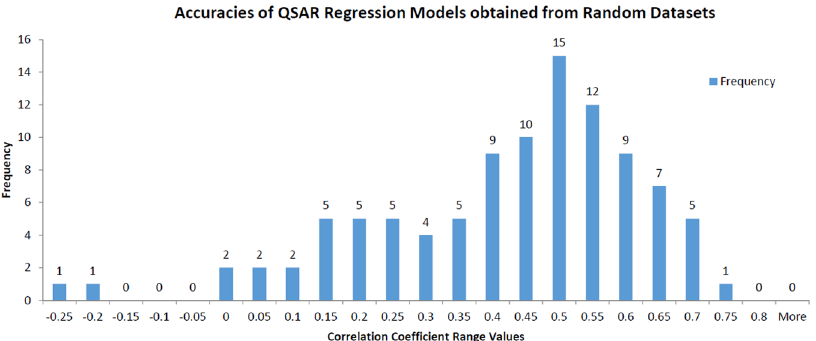
Figure 7. Accuracy frequency values for QSAR regression models computed using random combined subsets of